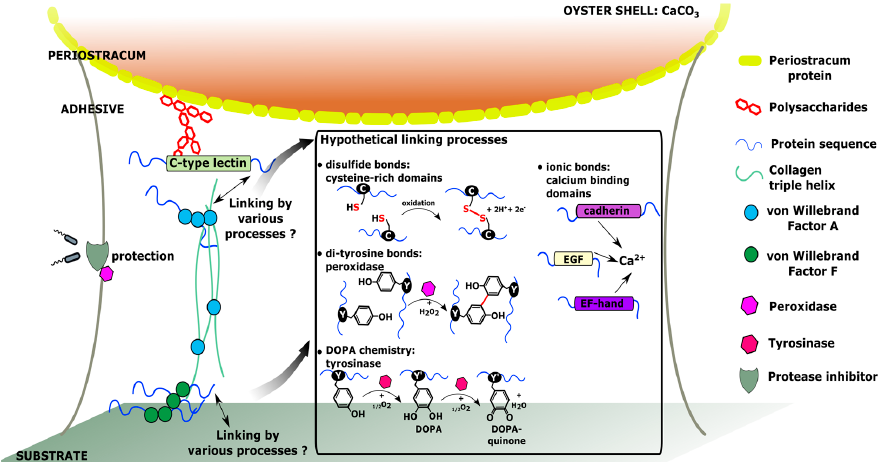
Figure 2. Schematic representation of the hypothetical molecular interactions involved in the adhesion of C. gigas pediveliger larvae, based on the selection of genes specifically expressed at the pediveliger stage.